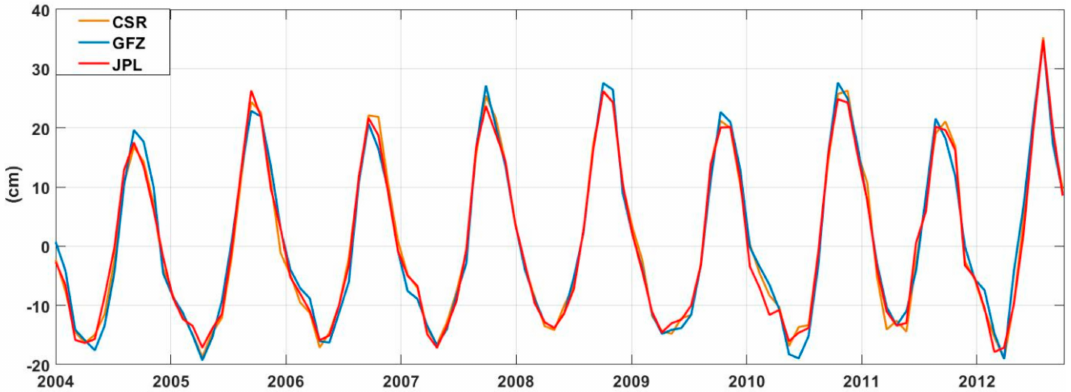
Figure 4. GRACE terrestrial water storage anomaly (TWSA) time series for the three solutions: CSR, GFZ and JPL for 9.5 ◦ N, 12.5 ◦ E from 2004 to